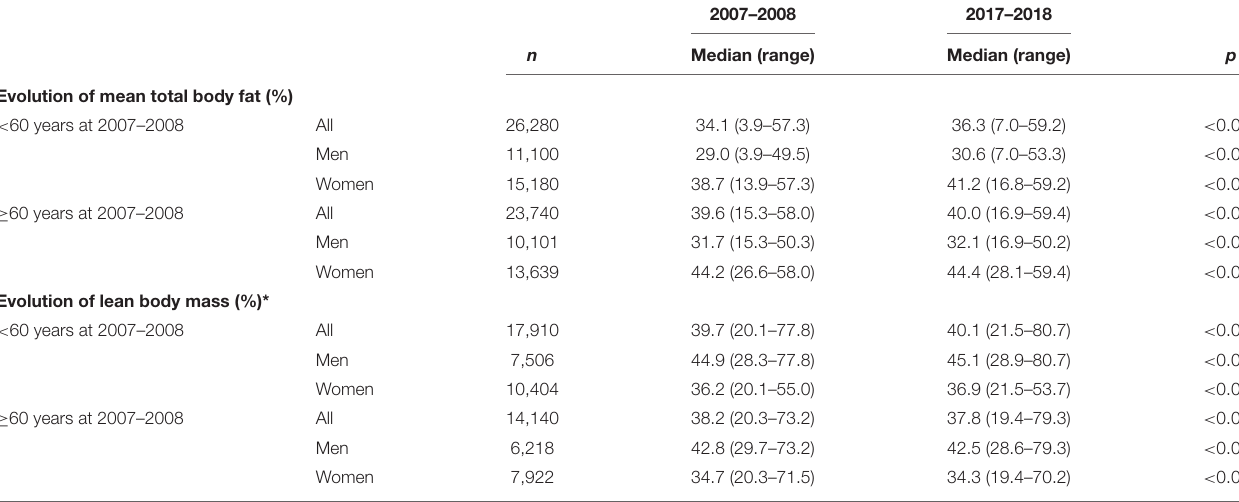
TABLE 4 | Ten-year evolution of the estimated mean total body fat and lean body mass in those participants younger and older than 60 years at the first evaluation.